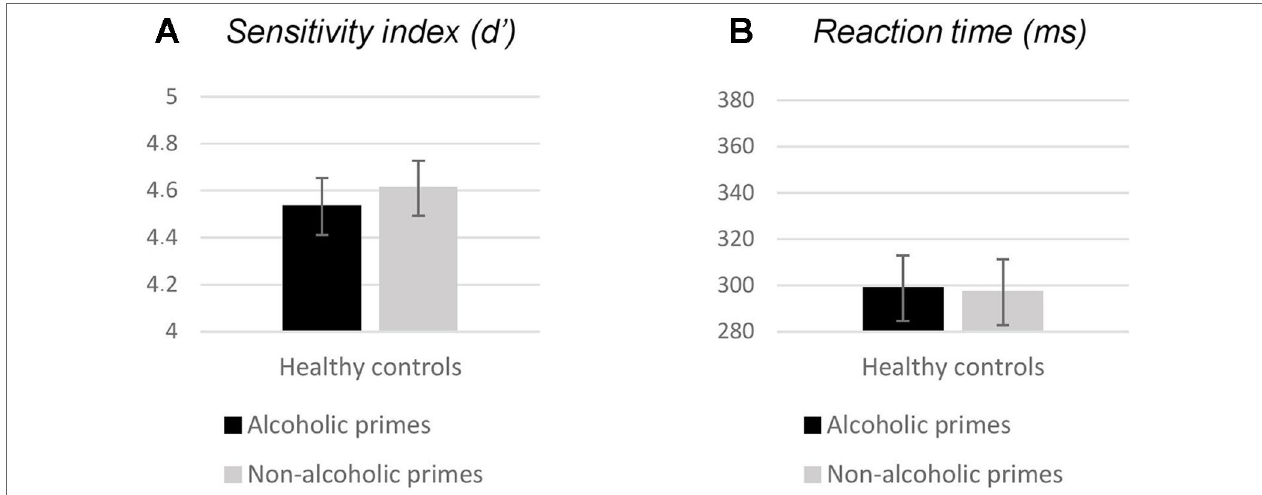
FIGURE 2 | Behavioral measures ( A : sensitivity index, B : reaction times) obtained in experiment 1. Bars represent mean; error bars depict standard errors. Reaction times were calculated for Go responses